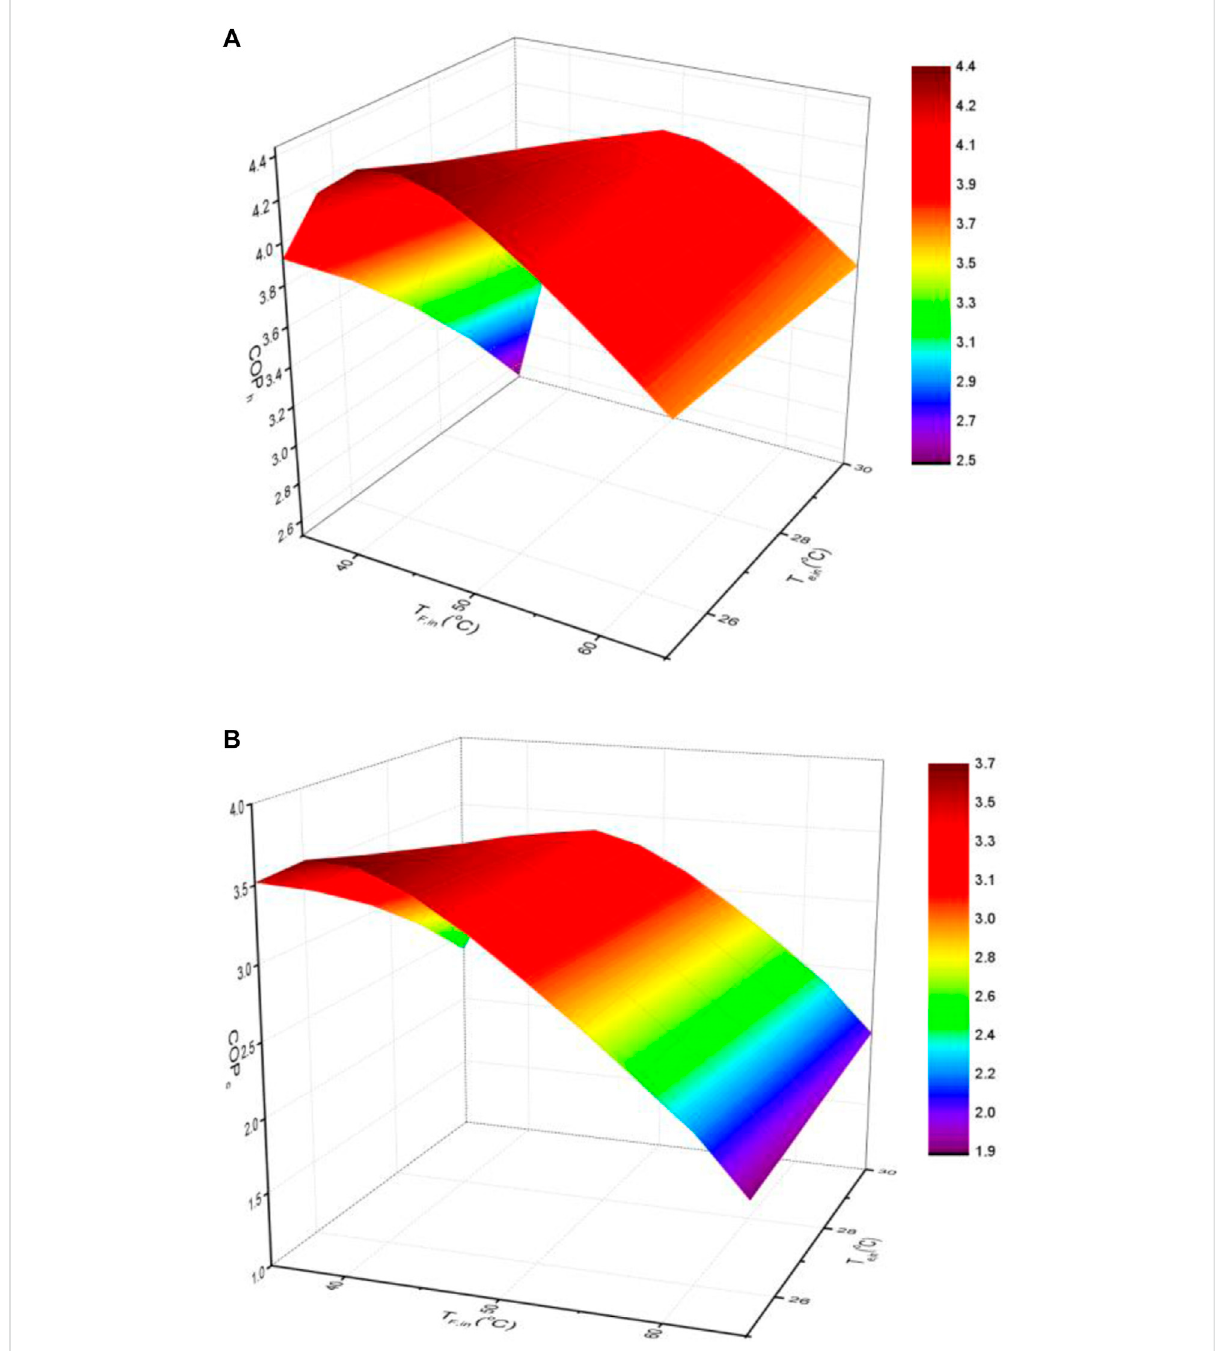
FIGURE 7 Effects of permeate temperature at the inlet of the evaporator and feed water temperature at the inlet of DCMD on COP h (A) and COP c (B)